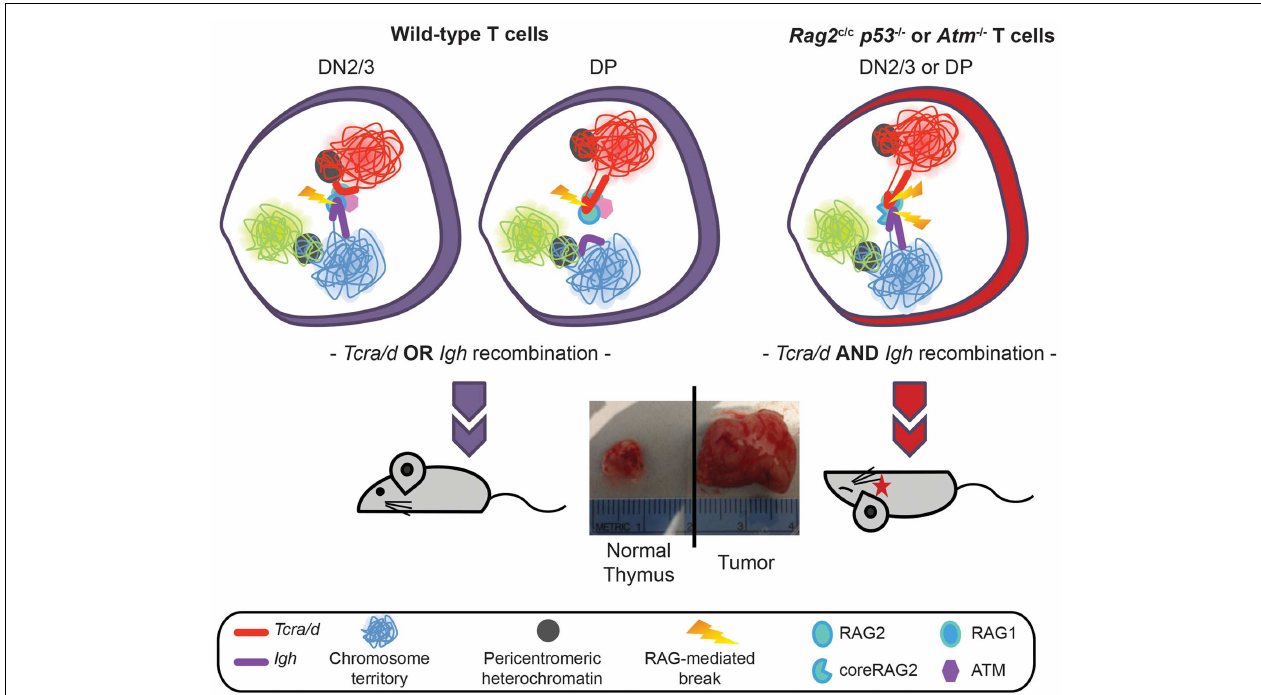
the RAG2 protein and ATM (that is recruited to the site of a DSB RAG break). Both factors control cleavage on the second locus by repositioning the uncleaved locus to repressive pericentromeric heterochromatin, inhibiting the formation of higher-order loops, and decreasing the frequency of pairing. In the absence of the C-terminus of RAG2 or ATM the two loci remain euchromatic, loops can form on both, and they stay paired at high frequency.This results in the introduction of bi-locus breaks and damage on closely associated loci, which provides a direct mechanism for the generation of these inter-locus translocations that are a hallmark of ATM deficient and Rag2 c/c